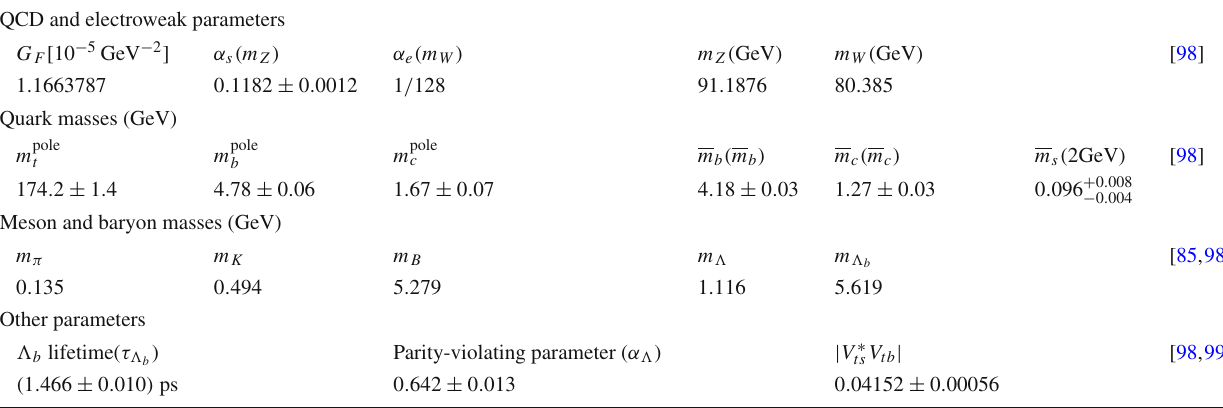
Table 1 Summary of the theoretical input parameters used throughout this paper QCD and electroweak parameters